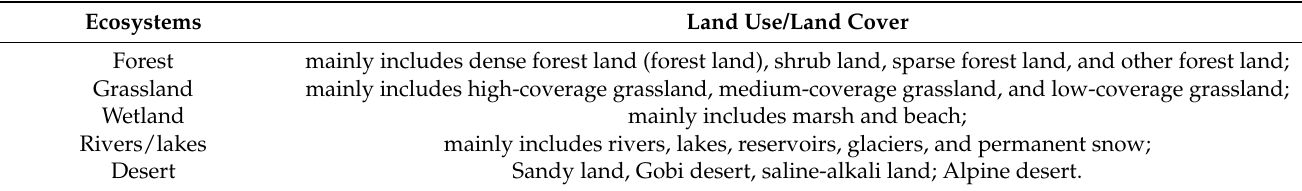
Table 1. Definition of terrestrial ecosystem types in ecospace of CPUA.